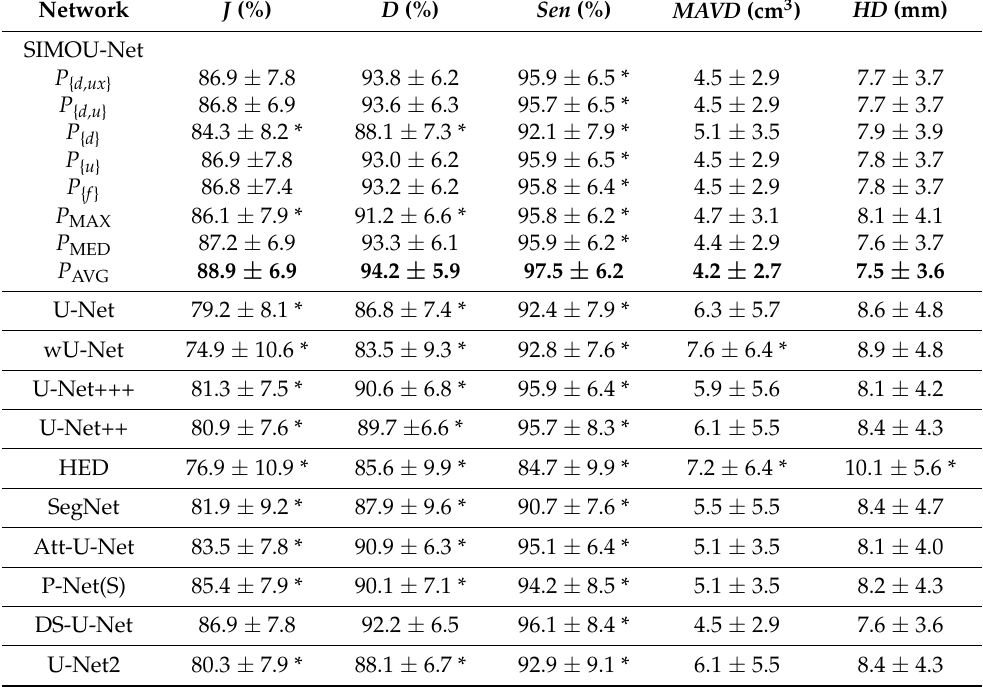
Table 1. Average quantitative results for 200 normal cases. Each numerical value represents the mean value ± standard deviation from stratified three-fold cross-validation. Bold typeface indicates the best performing method for each metric. * indicates a significant difference with respect to the P AVG score after performing a Nemenyi